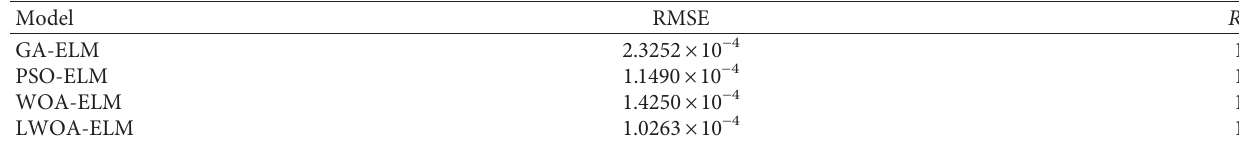
Table 3: Comparison results of the four